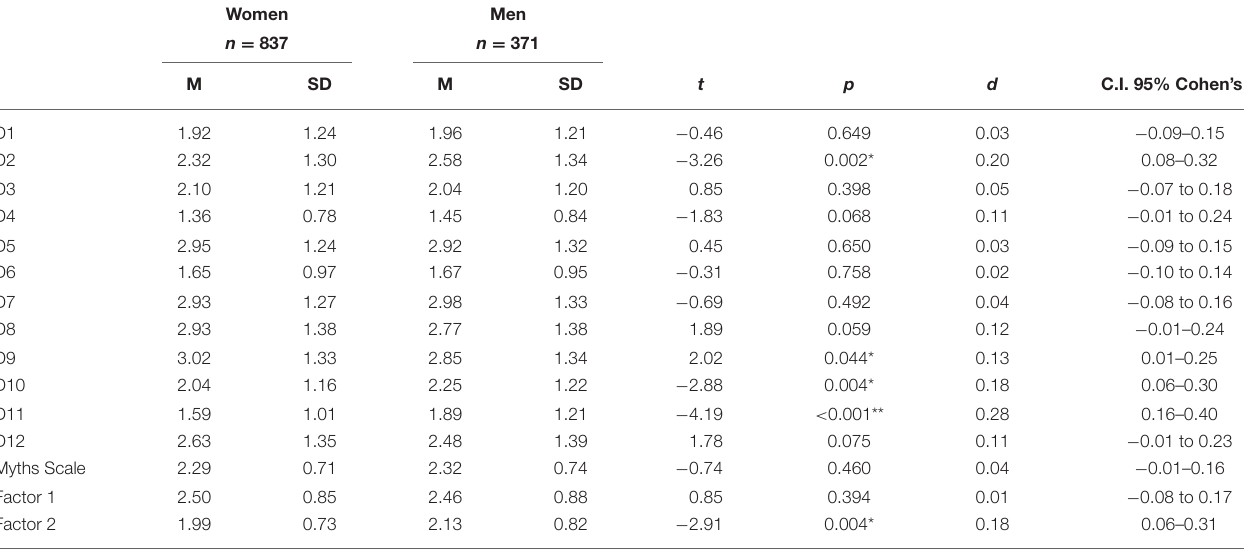
TABLE 2 | Descriptive and comparative analysis, according to sex, of the Scale of Myths of Romantic Love. Women